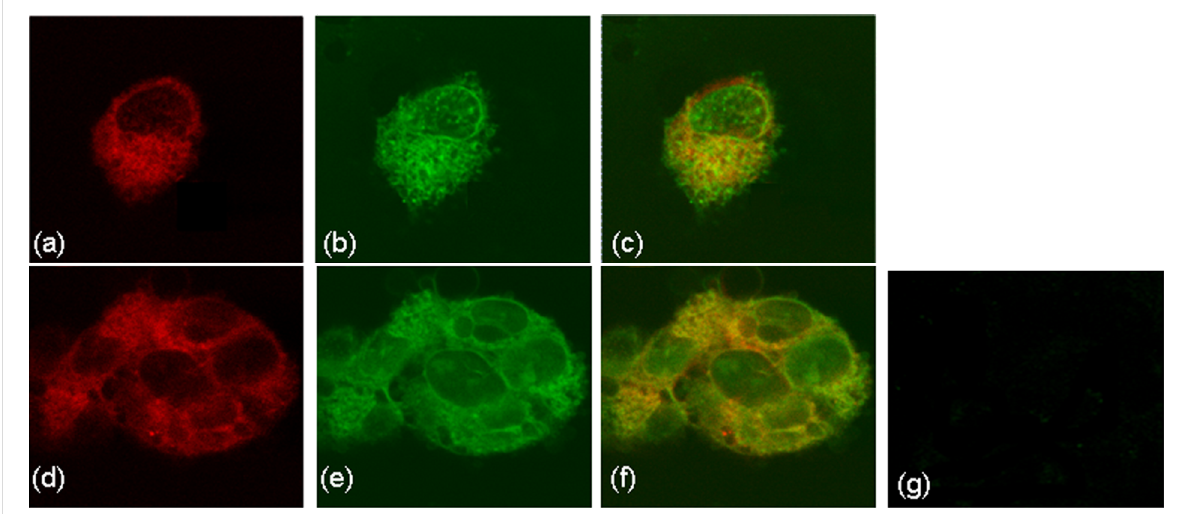
Figure 3: Representative confocal fluorescence microscopy images of MCF7 cells after incubation with a solution of 2 –fluorescein isothiocyanate- labeled 1-adamantylamine (1 mM/0.2 mM) PBS: (a, d) red fluorescence ( λ ex = 568 nm, λ em > 585 nm); (b, e) green fluorescence ( λ ex = 488 nm, λ em = 522 nm); (c, f) overlay of images a, b and of d, e: yellow color indicates guest co-localization with PpIX core; (g) blank experiment of fluorescein iso- thiocyanate-labeled 1-adamantylamine (0.2 mM in PBS, λ ex = 488 nm, λ em = 522 nm